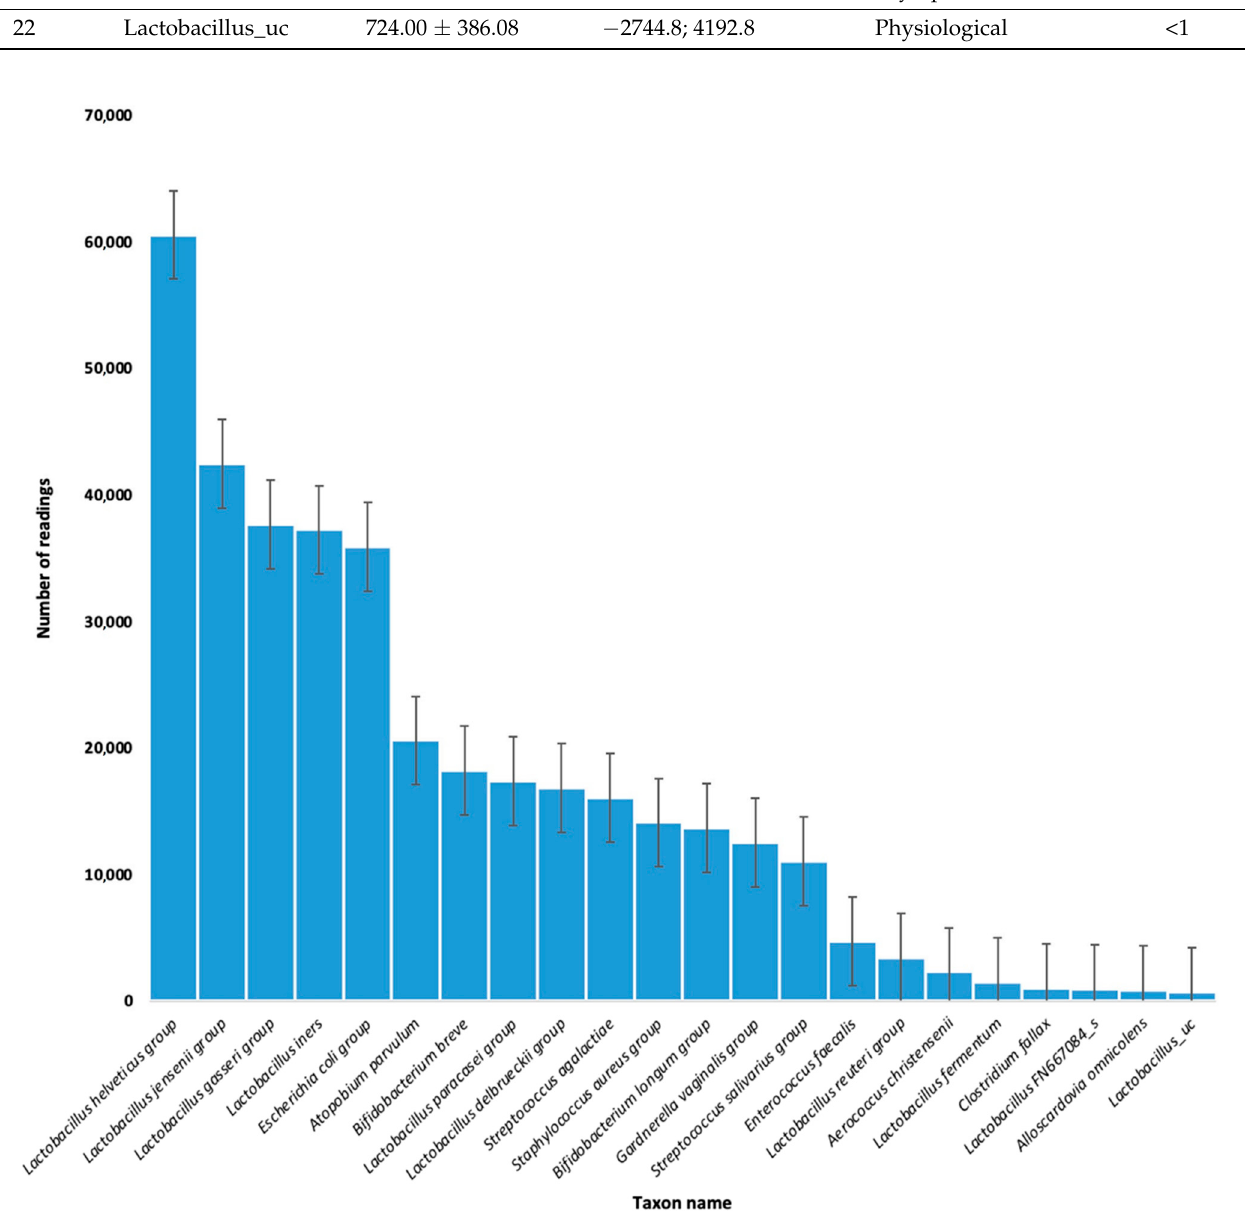
Figure 1. Number of readings of individual bacteria strains colonizing the endometrium and the uterine cervix of patients qualified for the IVF procedure.